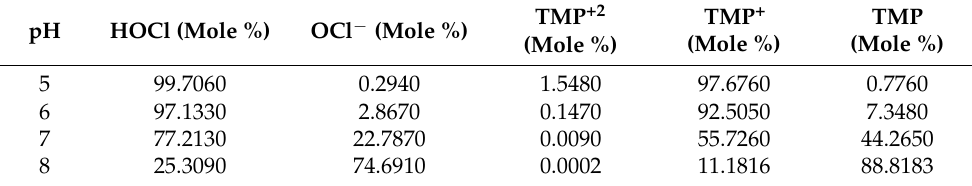
Table 1. Ionic species of the HOCl and TMP for the various pH